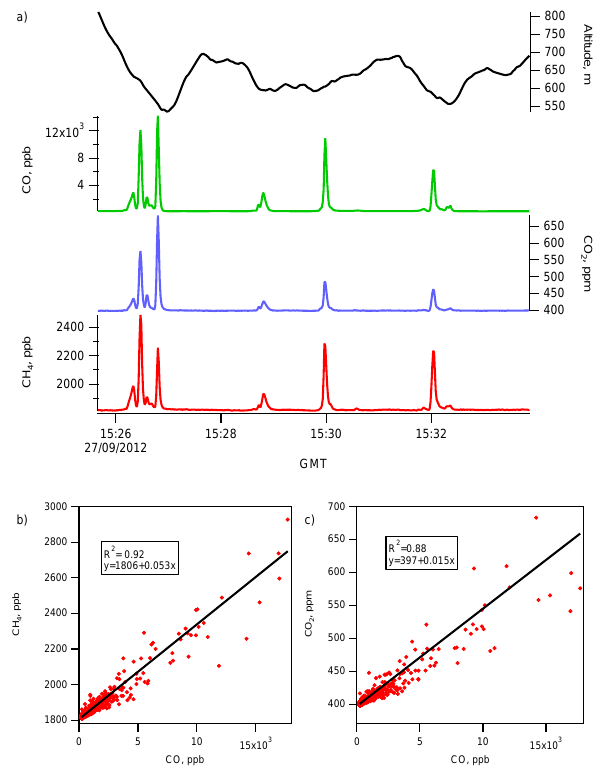
Fig. 8. (a) Shows a time series whilst flying in the bound- ary layer during flight B742 where a number of biomass- burning plumes were intercepted near Palmas, Brazil. Scat- ter plots for (b) CH 4 and (c) CO 2 both show strong corre- lation with CO and allow emission ratios to be determined, which were found to be 14.77 ± 0.03molCO 2 (molCO) − 1 and 0.0532 ± 0.0001molCH 4 (molCO) − 1 .